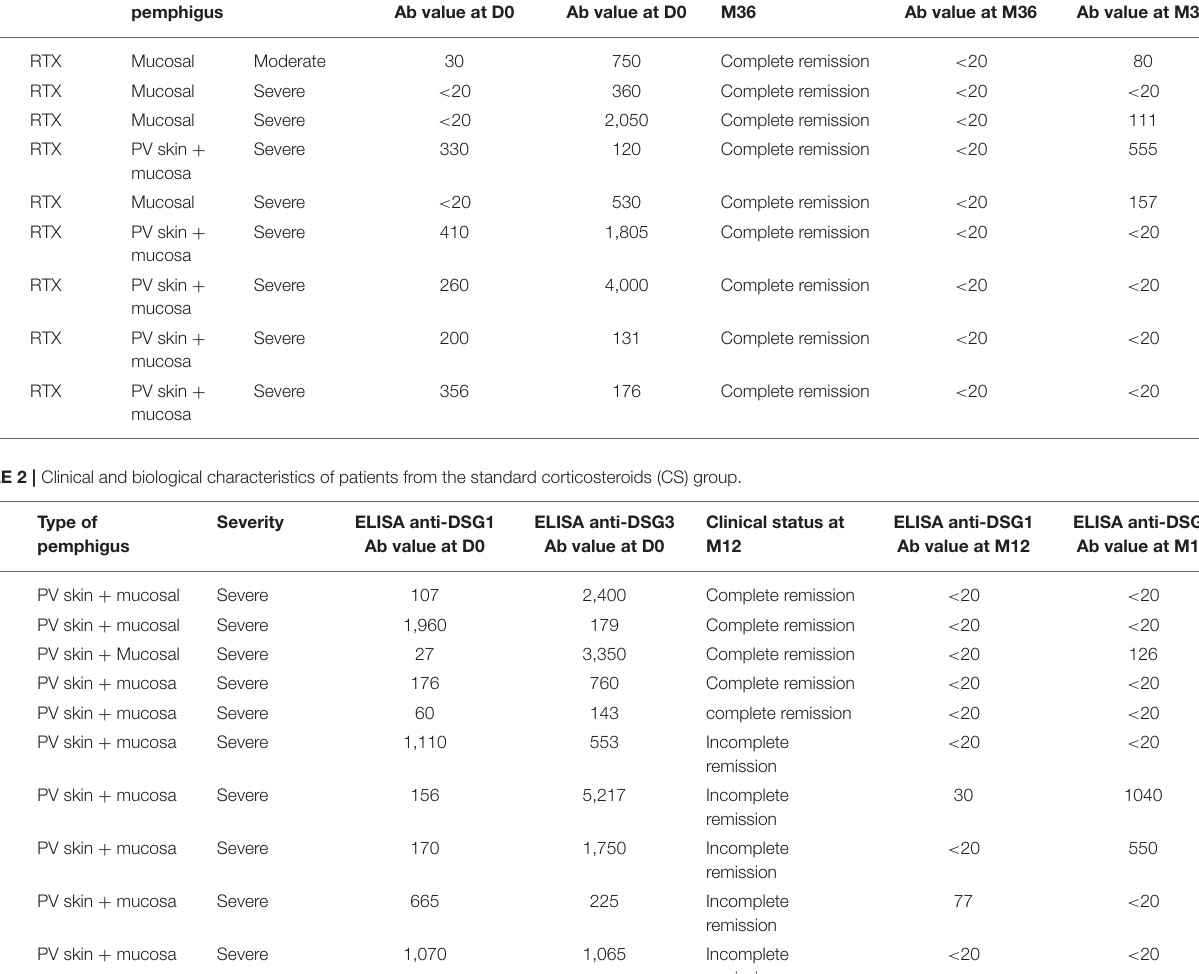
TABLE 1 | Clinical and biological characteristics of patients from the rituximab group. Age Treatment Type of Severity ELISA anti-DSG1 ELISA anti-DSG3 Clinical status at pemphigus Ab value at D0 Ab value at D0 M36